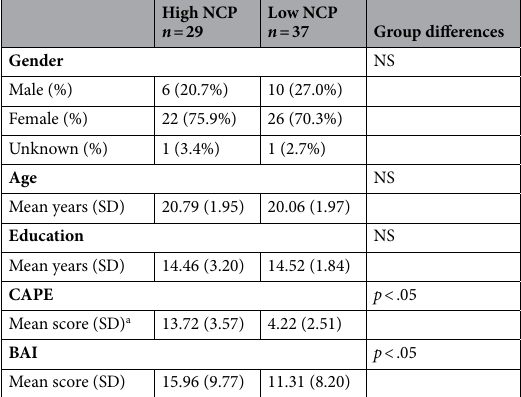
Table 1. Demographic characteristics. a CAPE frequency score from positive domain